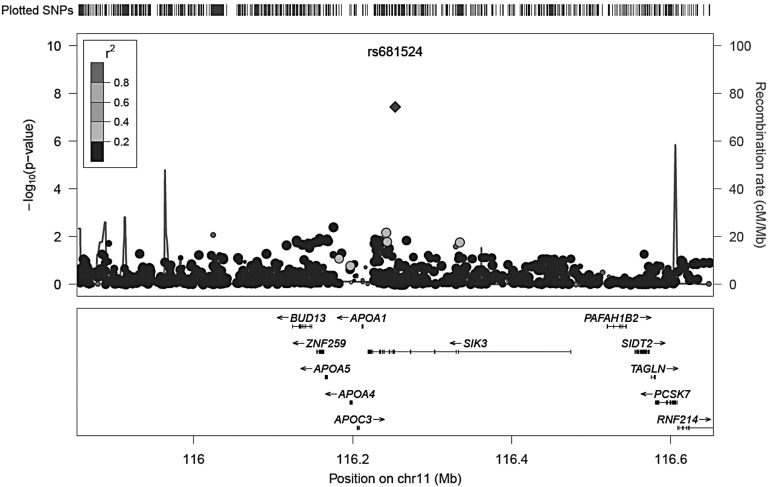
Locus zoom plot of the associated genetic markers on chromosome 11q23.3. The locus zoom depicts the location of genetic markers versus their significance of association with PC2. Significance of association is measured as the negative logarithm of the P-value. Genes located in the area 400 kb up-and downstream of rs681524 are displayed below the x-axis. The grey shading of each genetic marker indicates its correlation with the reference SNP rs681524. A legend for the correlation is shown in the upper left corner of the locus zoom. Recombination rate is highlighted as peaked lines.